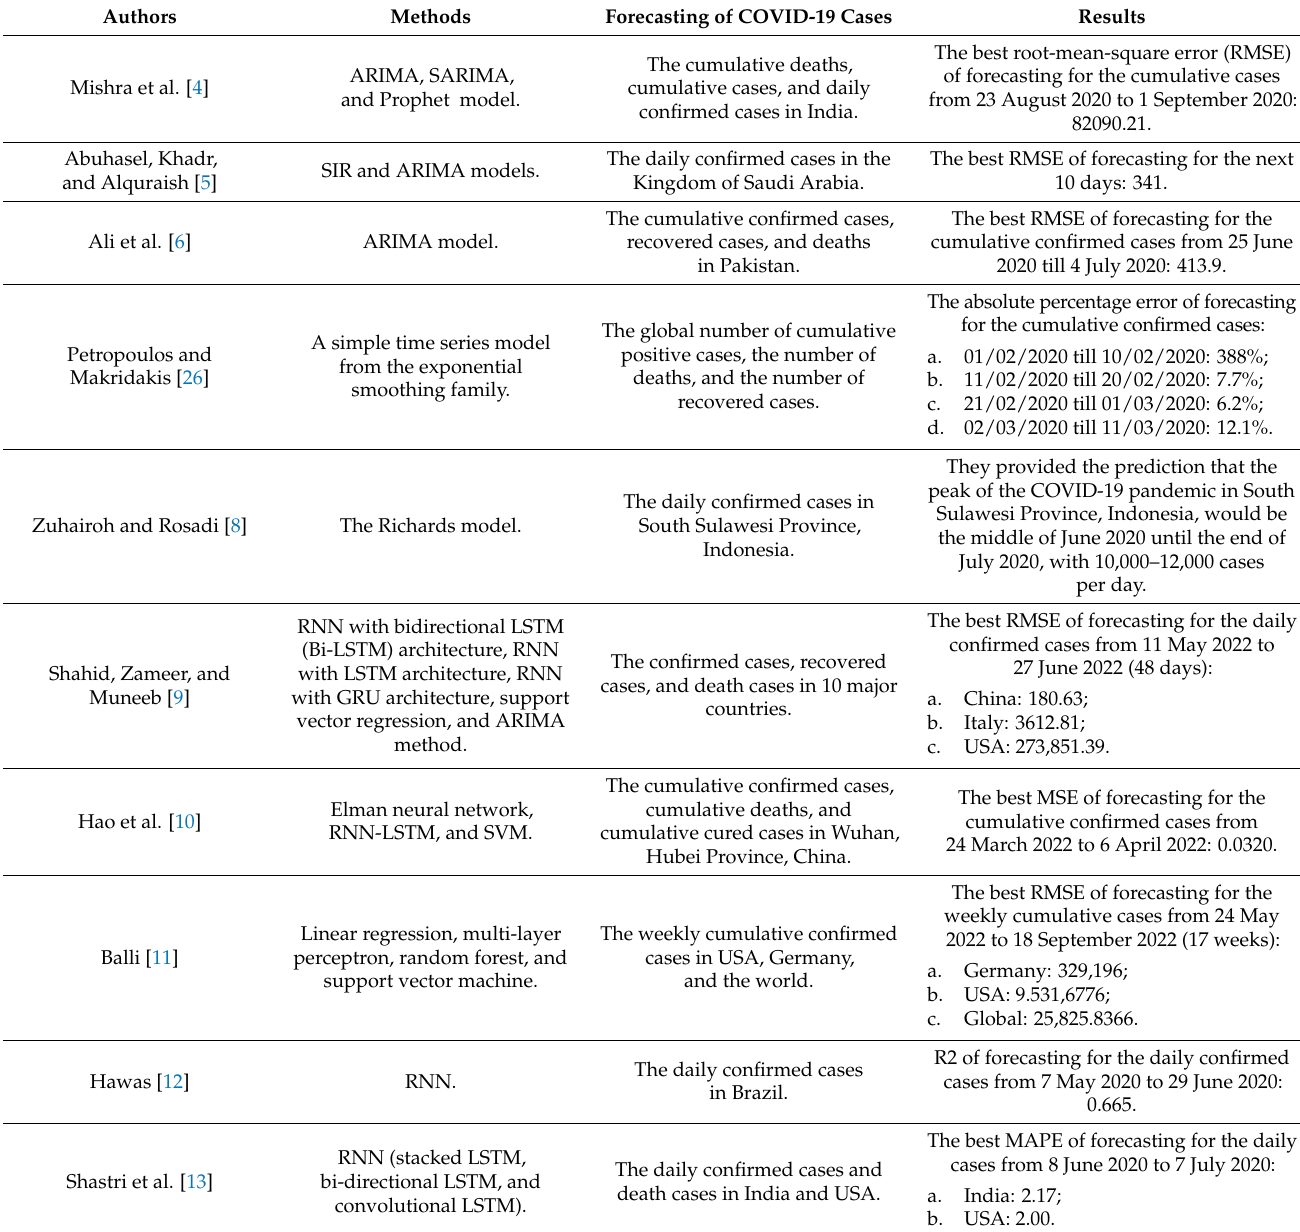
Table 1. Summarization of closely related